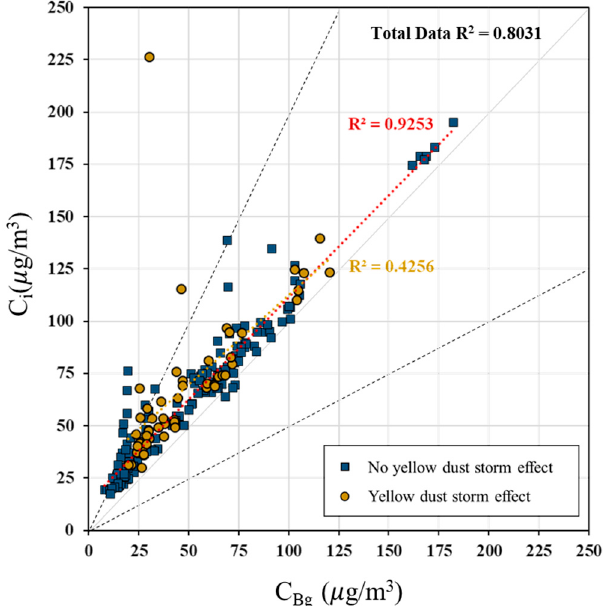
Figure 8. Concentration of C Bg vs. C i on paved roads during traffic operation (classification due to yellow dust impact).